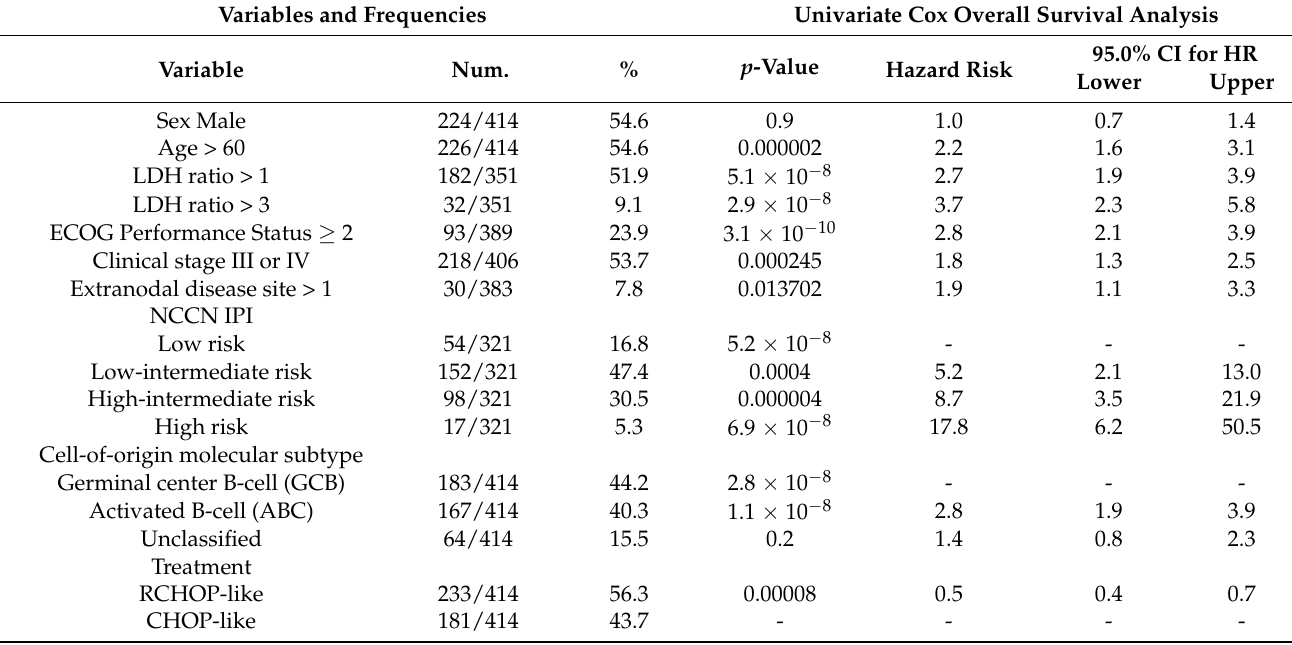
Note: The GSE10846 dataset represents previously published data of the LLMPP [24,25], which is not the authors’ own work. This dataset is publicly available as the Gene Expression Omnibus data repository of the National Center for Biotechnology Information (NCBI). NCCN, National Comprehensive Cancer